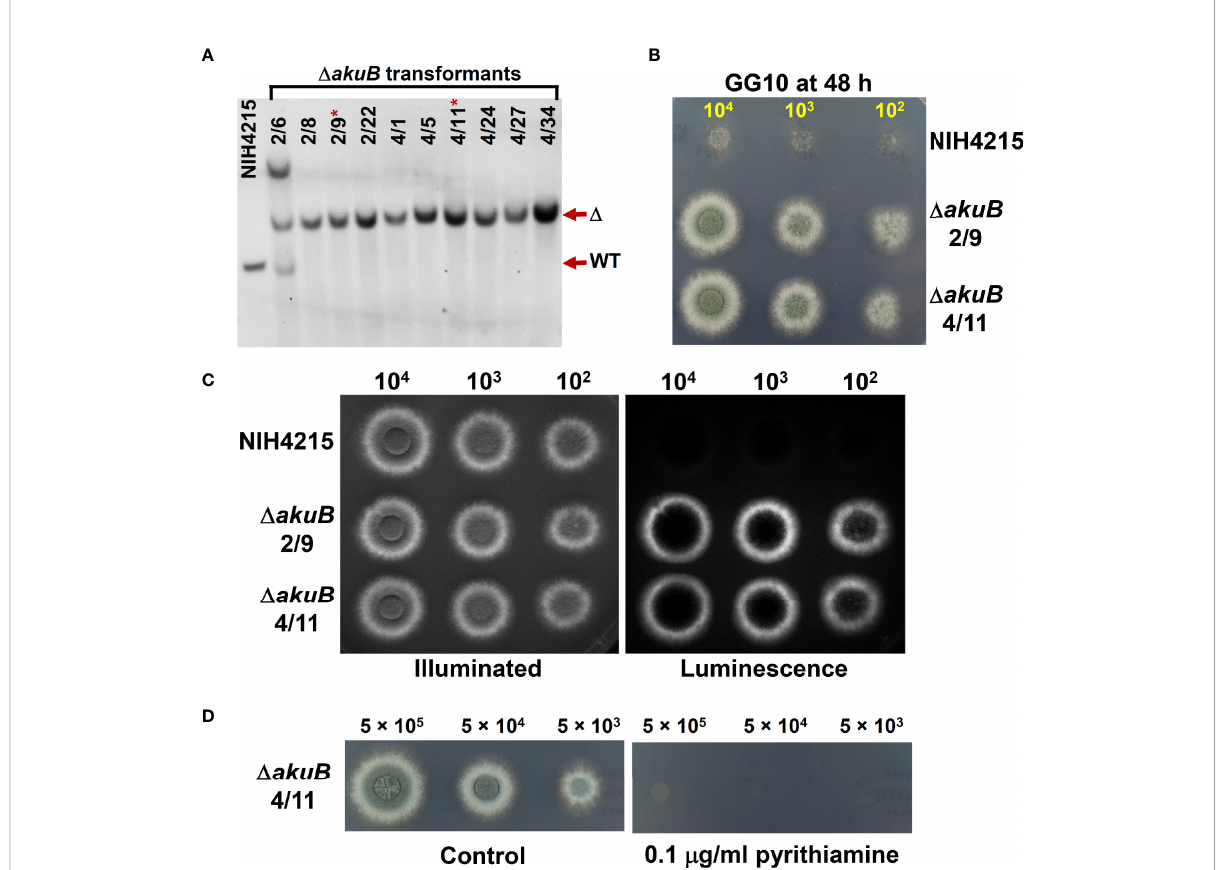
FIGURE 4 Southern blot and bioluminescence of D akuB strains generated by use of a wild-type nmt1 gene as transformation marker. (A) Southern blot analysis of selected transformants. A digoxygenin-labelled probe against the downstream region of the akuB gene was used and genomic DNA was restricted by Bam HI resulting in expected signals at 2872 bp for the wild type (WT) and 4111 bp for deletion mutants ( D ). All transformants selected from PCR pre-screening showed the expected deletion signal with transformant 2/6 showing two additional integrations. Strains 2/9 and 4/11 (indicated by *) were selected for subsequent experiments. (B) Growth of the selected D akuB strains on thiamine-free minimal medium containing 50 mM glucose as carbon and 10 mM glutamine as nitrogen source (GG10). Serial dilutions of spore suspensions were spotted as indicated and pictures were taken after 48 h at 37°C. The akuB deletion mutants are prototrophic for thiamine. (C) Same as in (B) , but plates contained 25 µg/ml thiamine to enable growth of strain NIH4215 and 0.3 mM D -luciferin to allow for bioluminescence imaging. Left side picture is an acquisition under illumination and right side the luminescence acquisition in the dark. Note that pigmented conidia on top of colonies quench the light emission. Both selected strains show the expected bioluminescence, which is not observed for the parental strain. Pictures were taken after 42 h. (D) Test of pyrithiamine resistance of the selected D akuB strain 4/11. Conidia suspensions were spotted on GG10 medium with or without pyrithiamine supplementation. Introduction of the nmt1 wild-type gene confers pyrithiamine